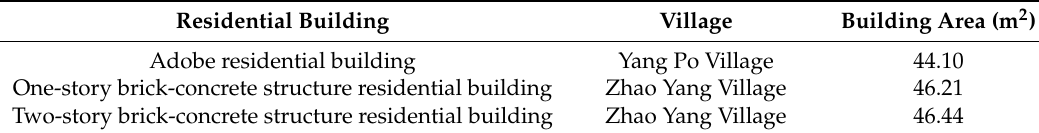
Figure 5. Present situation of the three typical residential buildings